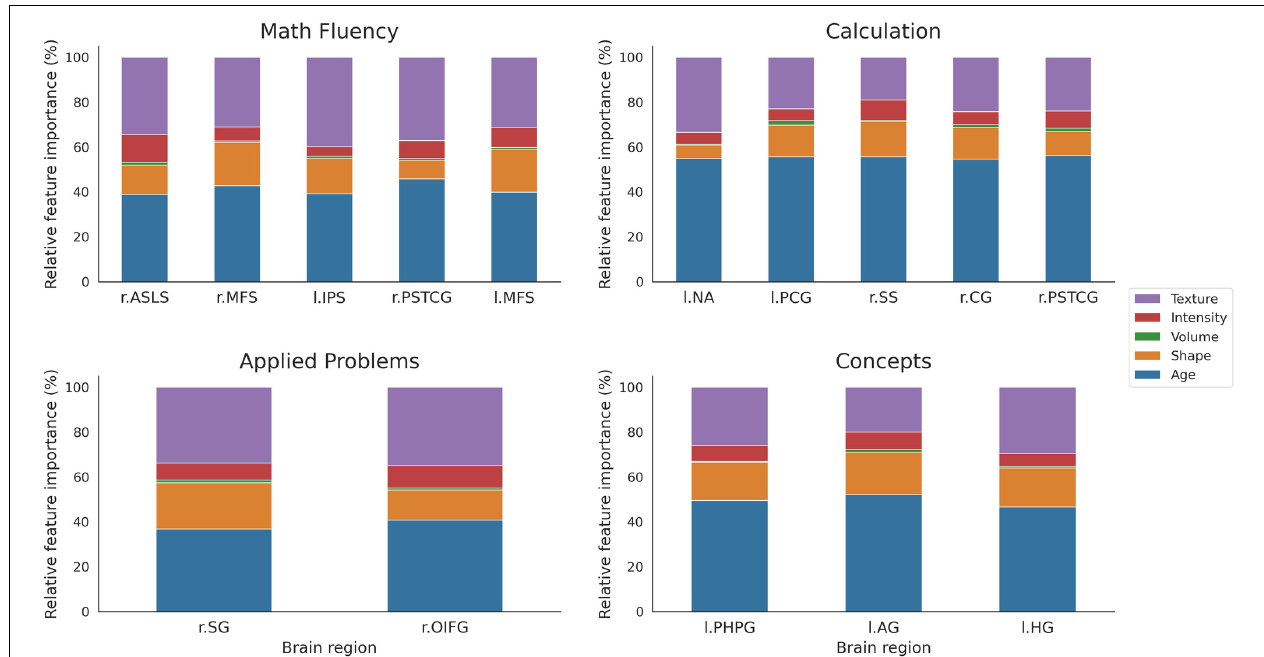
FIGURE 8 | Relative percentage of variable importance presented by feature group for the selected brain areas. The total sum is rescaled to 100% to better appreciate differences between features. Note the smaller size of volume (green) compared with shape (orange) or texture (purple) features. Brain areas: ASLS [vertical ramus of the anterior segment of the lateral sulcus (or fissure)], MFS (middle frontal sulcus), IPS (intraparietal sulcus and transverse parietal sulci), PSTCG (post-central gyrus), NA (nucleus accumbens), PCG (middle-posterior part of the cingulate gyrus and sulcus), SS [suborbital sulcus (sulcus rostrales, supraorbital sulcus)], CG (cuneus gyrus), OIFG (orbital part of the inferior frontal gyrus), PHPG (parahippocampal gyrus, parahippocampal part of the middle occipito-temporal gyrus), AG (angular gyrus), HG [anterior transverse temporal gyrus [of